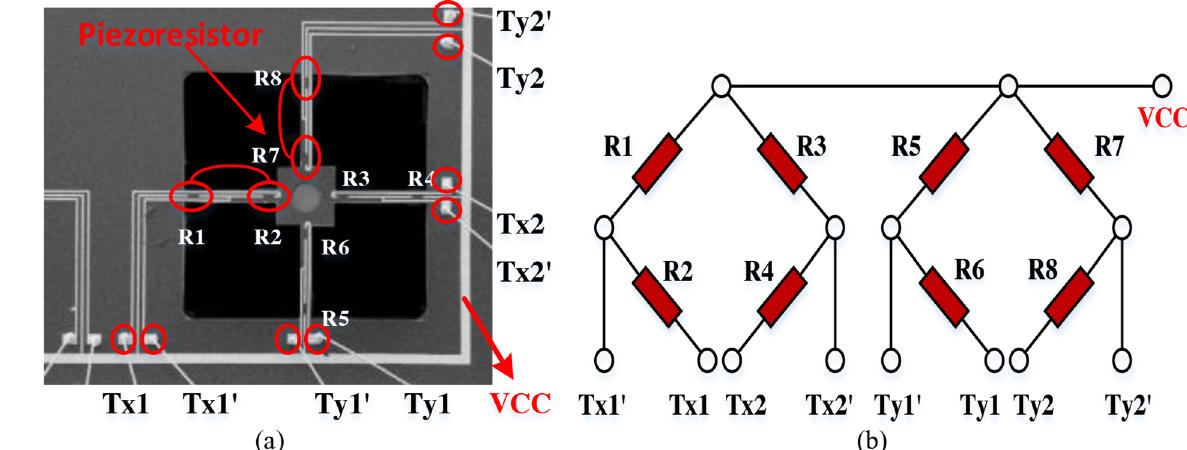
Fig. 14. Testing method of piezoresistors on the cantilever. (a) Distribution of piezoresistors on the cantilever beams in a unit (b) the connection of equivalent